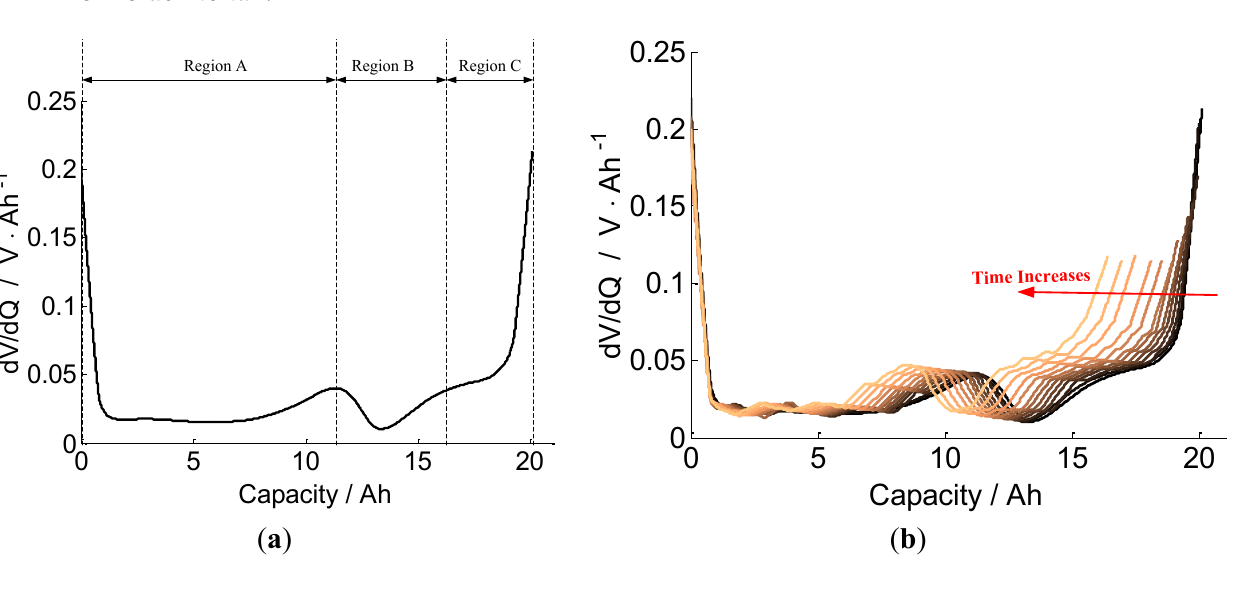
Figure 9. ( a ) The differential voltage (DV) curve of new Cell A; and ( b ) the DV curves of Cell A after every 90 cycles up to 1080 cycles; with cycle number increase, color changes from black to tan.